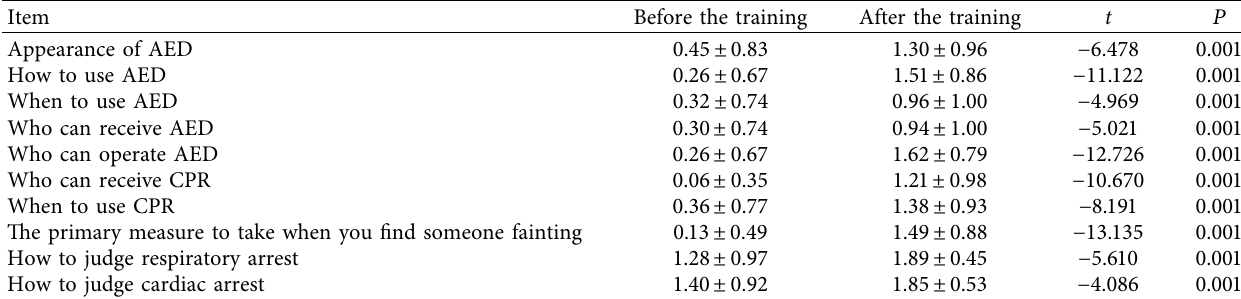
Table 2: Comparison of BLS knowledge score of residents before and after training ( x ± s , scores).